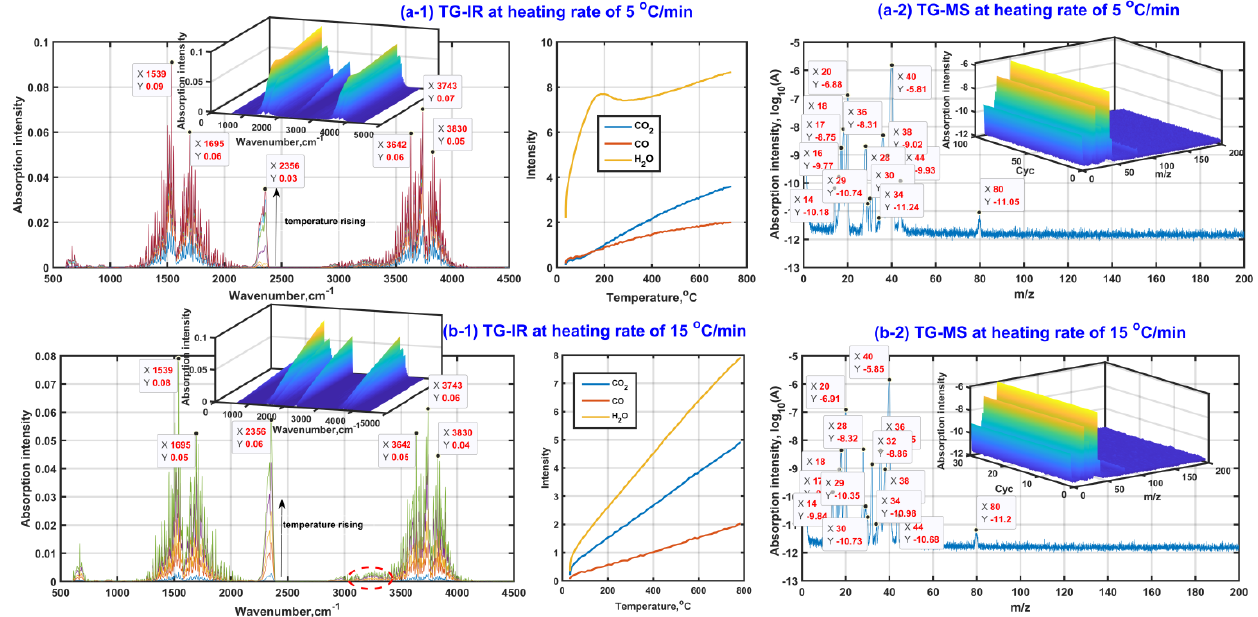
Figure 2. Gas product analysis (( a-1 , b-1 ) based on in situ TG-FTIR; ( a-2 , b-2 ) based on in situTG-MS).